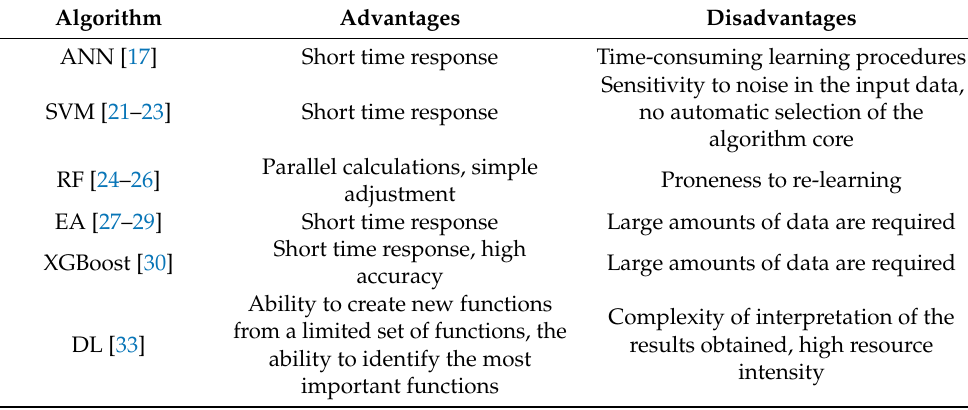
Table 1. Comparison of ML